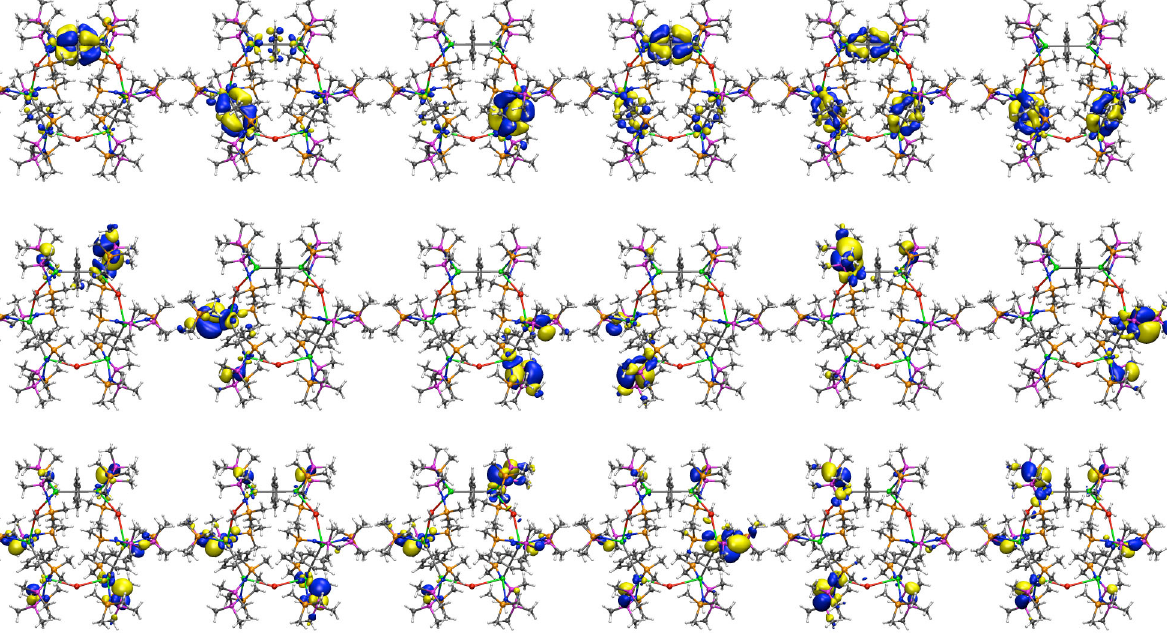
Fig. 8 Computed DFT molecular orbitals for 4 ′ . Top row: the six uranium – arene δ -bonding interactions. Middle and bottoms rows: the 12 U = C π -double bond interactions. Key: uranium, green; iodide, red; phosphorus, purple; nitrogen, dark blue; carbon, grey; hydrogen, white ′ = ′ ( 3 ′ , BIPM L C(PMe 2 NSiMe 3 ) 2 ) and [{U(BIPM L )} 6 ( μ -I) 3 ( μ - η 6 : η 6 -C 4 ′ , BIPM L ′ = C(PMe 6 H 6 ) 3 ] ( 2 NSiMe 3 ) 2 ) to explore the nature of the U – C BIPM interaction. At the DFT level, only the high spin S = 9/2 state was computed for 3 ′ and 4 ′ since lower spin states are spin-contaminated. The 12 orbitals with contribu- tions primarily from the C BIPM 2 p orbitals, but also with contributions from the uranium centres, are shown in Fig. 8. for U = C BIPM give values ranging from 1.15 to 1.16 for 3 ′ and